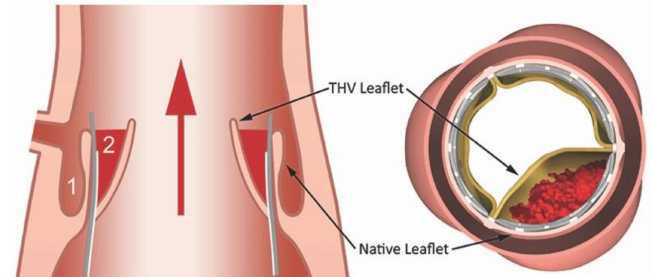
Figure 1. The native sinus and neosinus. Deployment of the transcatheter heart valve (THV) results in the displacement of the native aortic valve leaflets. The displaced native valve leaflets divide the aortic sinus into two parts—a neosinus (1) and native sinus (2). Flow stagnation in the neosinus appears to be a key driver of thrombus formation in the context of TAVI. Reproduced with permission from Yoganathan A, The Fluid Mechanics of Transcatheter Heart Valve Leaflet Thrombosis in the Neosinus; published by Lippincott Williams & Wilkins, 2017